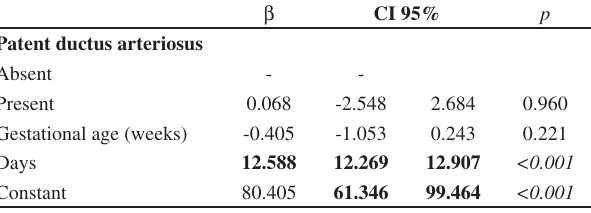
Table 9 - Generalized estimation equation (GEE) model to assess the association between weight loss during the first week of life and patent ductus arteriosus.